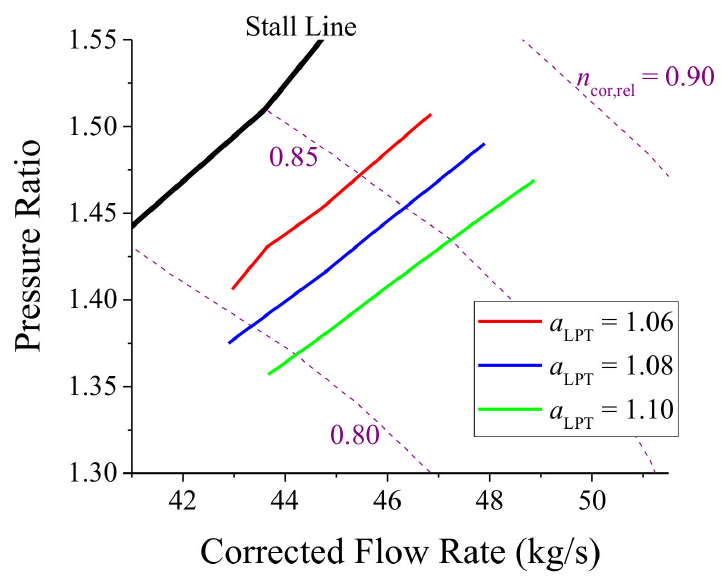
Figure 41. The Variations of the Matched Operating Lines of AFS at the conditions of Different Throat Area Coefficients of Low-Pressure Turbine Inlet Guide Vane ( α LPT